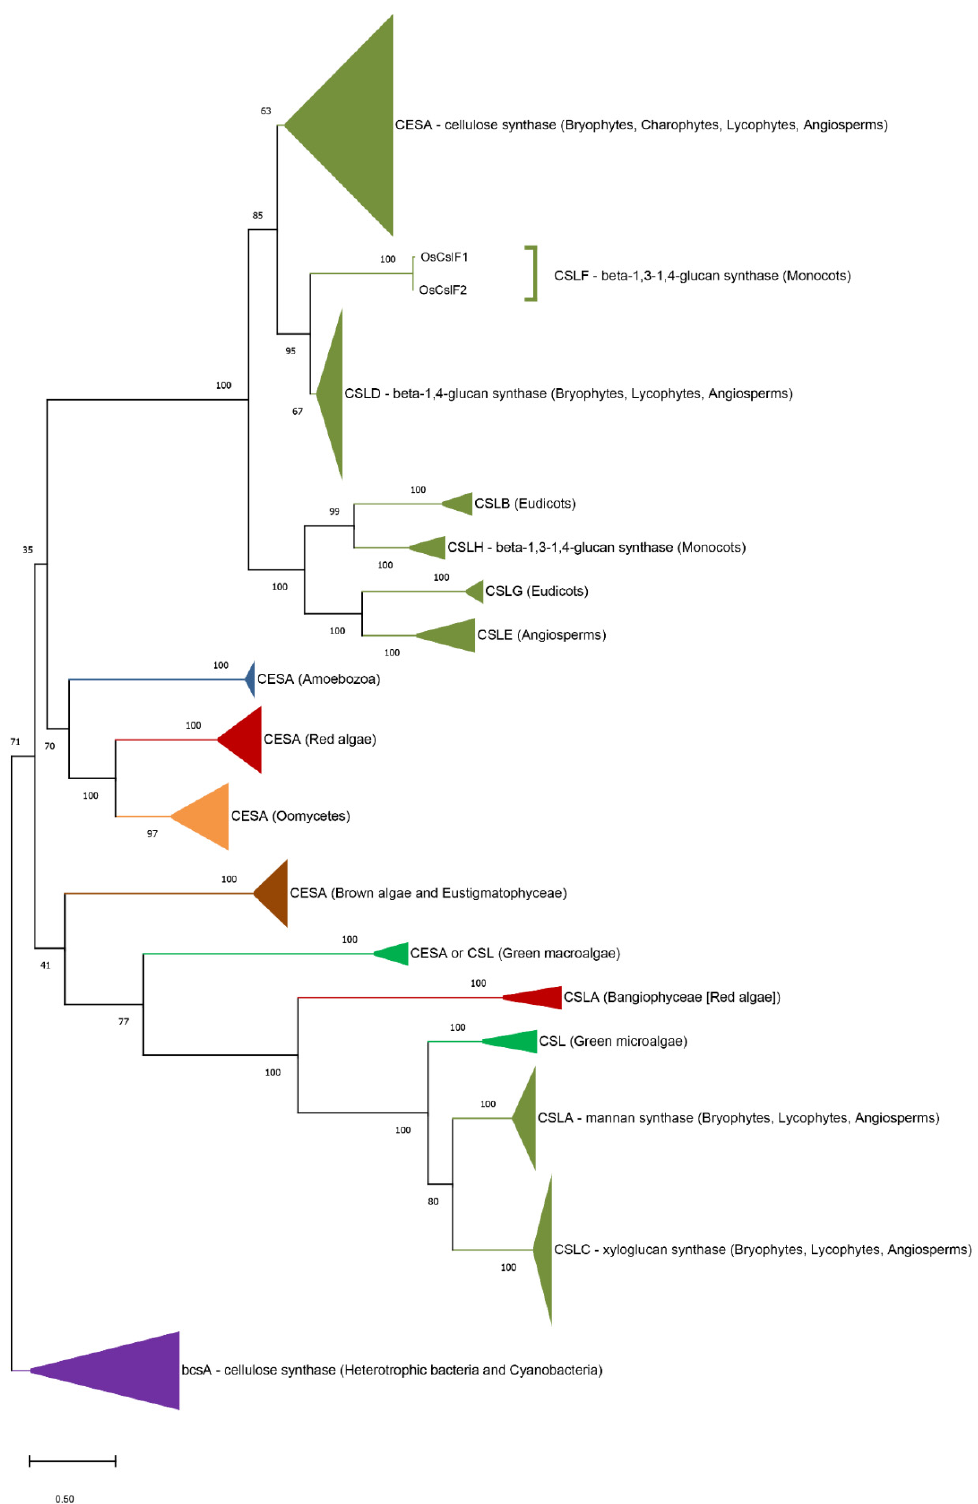
Figure 3. Phylogenetic tree of the cellulose synthases (CESA) and cellulose synthase-like proteins CSL (family GT2). The phylogenetic tree was constructed using the Maximum Likelihood (ML) approach with the program MEGA-X [82]. Numbers indicate the bootstrap values in the ML analysis. Bootstrap values inferior to 50% are not shown. The tree was rooted by the clade of bacterial cellulose synthases. The full listing of the aligned proteins is reported in Supplementary Table S1. The uncompressed tree is shown in Supplementary Figure S1.